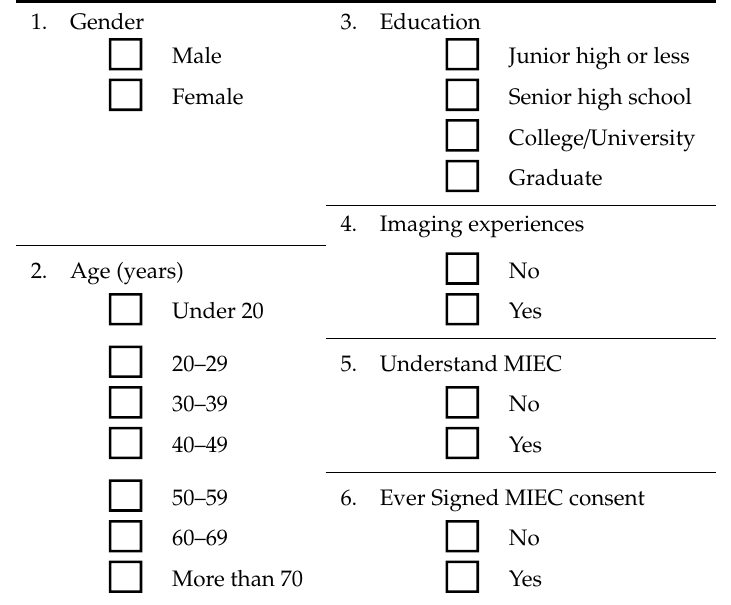
Table A2. Questionnaires: Citizens’ Information Privacy Concerns and Their Intention to Use MIEC. Questions